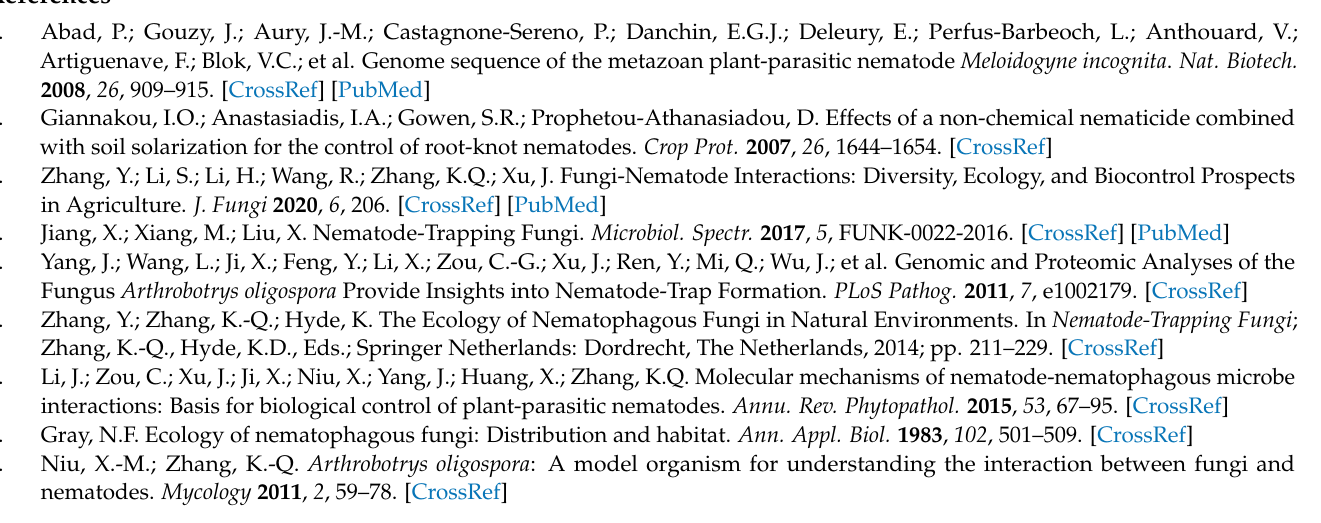
Supplementary Materials: The following are available online at https://www.mdpi.com/article/10 .3390/microorganisms9091919/s1. Figure S1: Genetic clustering of 239 A. oligospora isolates from China based on 20 STR loci by Nei’s distance. Notes: Scale bar indicates percentage identity. Figure S2: Mantel tests of the relationships among genetic differentiation (Nei values) and geographical distance. 14 Pairwise tanglegrams between single gene phylogenies. Notes: Hybrids indicated by structure analysis are colored in green on the tanglegram. Figure S4: Bayesian phylogeny for the MLST SNPs. Table S1: Length and polymorphism information of six sequenced DNA fragments. Table S2: Pairwise differentiations of A. oligospora isolates from 16 geographic populations from China based on MLST dataset. Notes: Values in the bottom left represent PhiPT values, while those in the top right represent p values. Table S3: Pairwise differentiations between 19 geographic populations of A. oligospora in China based on the STR dataset. Notes: Values in the bottom left represent PhiPT values, while those in the top right represent p values. Table S4: Pairwise differentiations between 19 geographic populations of A. oligospora in China based on a combined MLST and STR dataset. Notes: Values in the bottom left represent PhiPT values, while those in the top right represent p values, Table S5 List of samples used in Figure